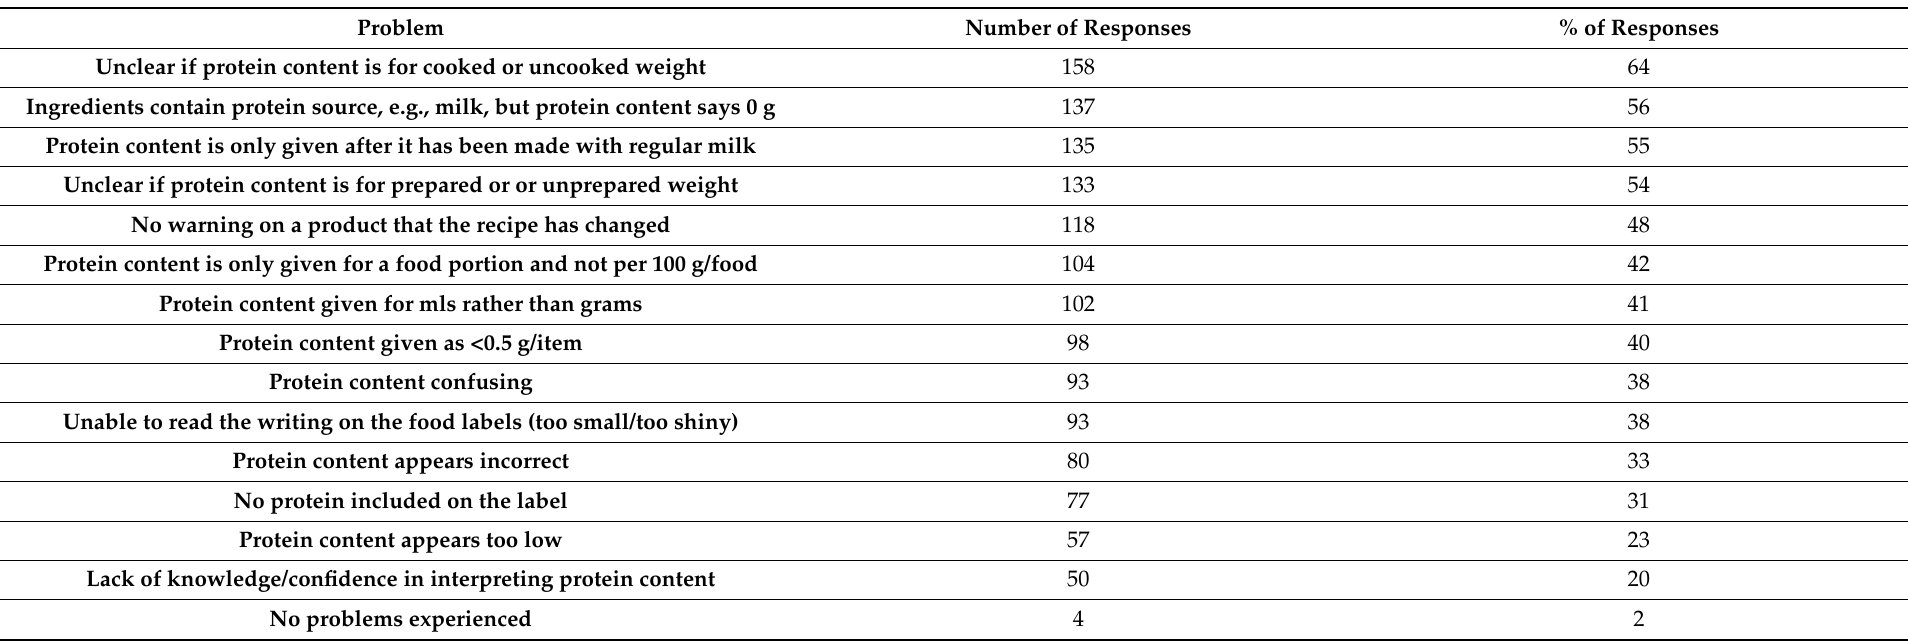
Table 3. Issues associated with food protein labelling identified by respondents ( n = 246). NB: respondents could choose more than one